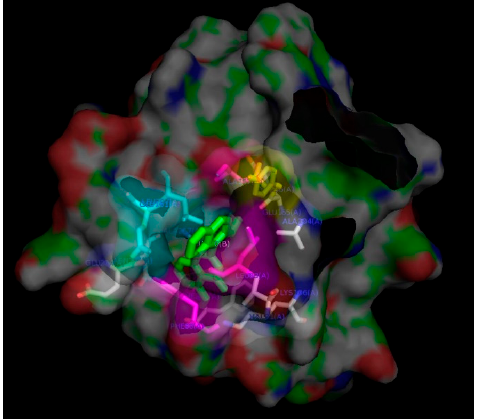
Figure 8. Image of the binding pocket of the AURKB–derivative 31 complex visualized using the PyMol program. Derivative 31 and Tyr156 are colored in green and yellow, respectively. Leu83, Phe88, Ala157 and Leu207 are marked in magenta color. Glu161 is marked in cyan color.